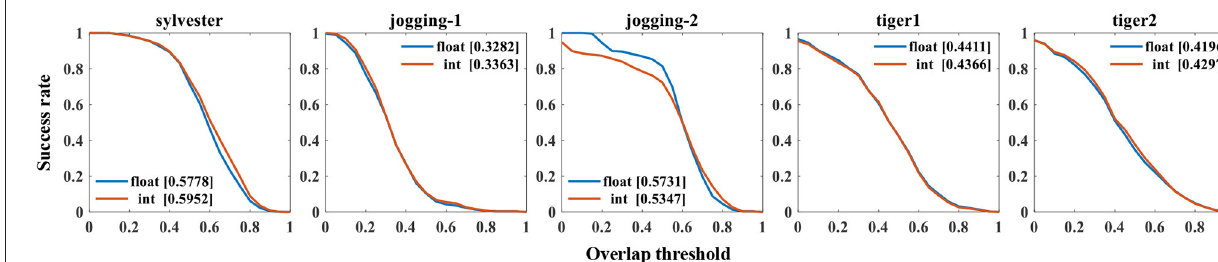
FIGURE 14 | Influence of the data quantization.